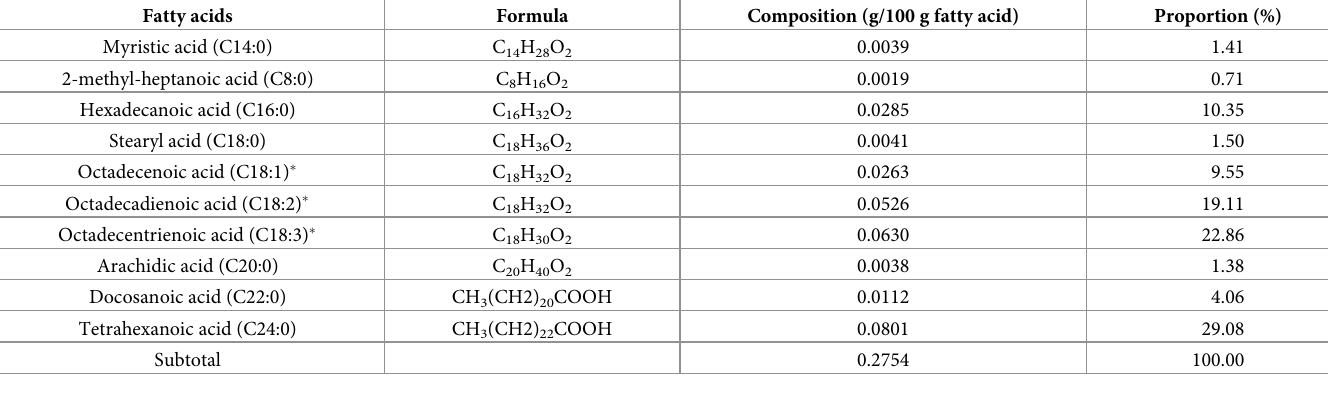
Table 3. Fatty acid content in Berberis heteropoda